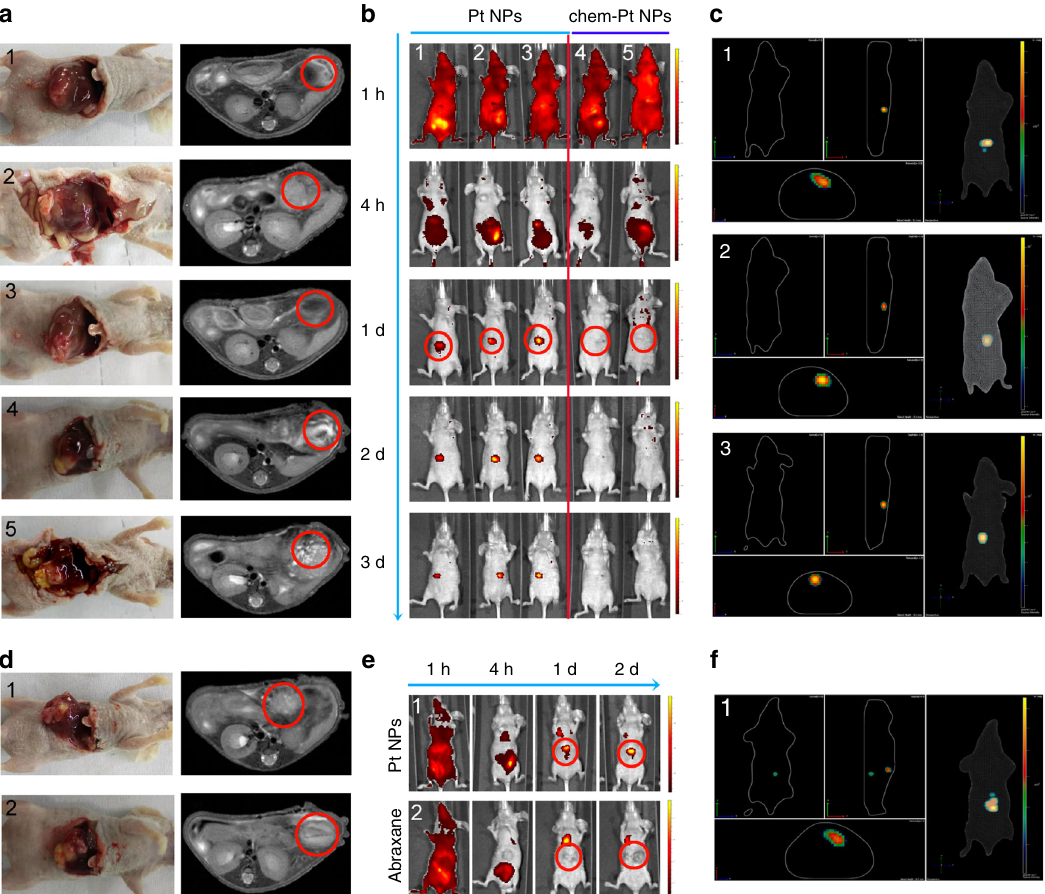
Fig. 5 Orthotopic livertumor targeting of Pt NPs in vivo. a Anatomical location (left) and MIR imaging (right) of orthotopic liver tumors in 5 nude mice; b NIR image of tumors 1 – 3 d after intravenous injection with 1 mg kg − 1 ICG-conjugated Pt NPs (1, 2, 3) or 1 mg kg − 1 ICG-conjugated chem-Pt NPs